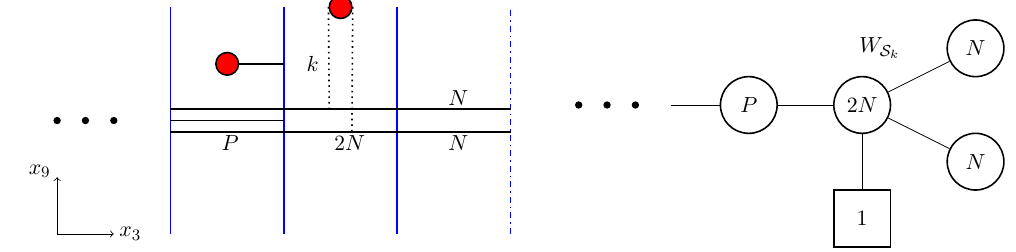
Figure 60 . Type IIB configuration corresponding to a Wilson defect for the U(2 N ) gauge group in the generic D -type quiver discussed above. The blue dot-dashed line denotes the Orb5-plane. The black dotted vertical lines denote k configuration corresponds to a Wilson defect in a representation R = S